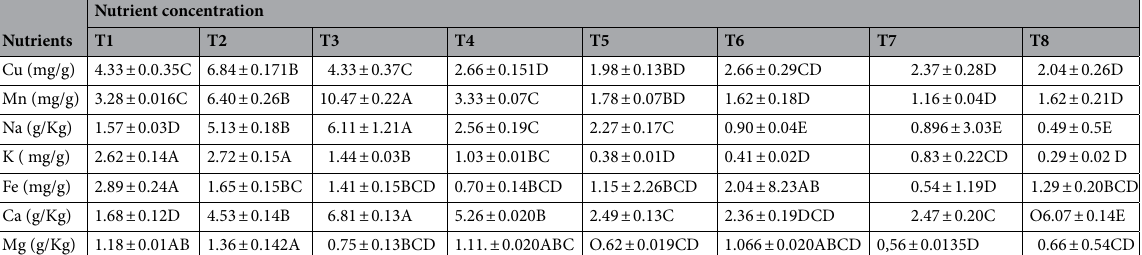
Table 2. Accumulation of micro and macro nutrients by maize plants. All treatments sharing common letter are similar otherwise differ significantly at p < 0.05. T1 = control, T2 = inoculated seed, T3 = 0.25